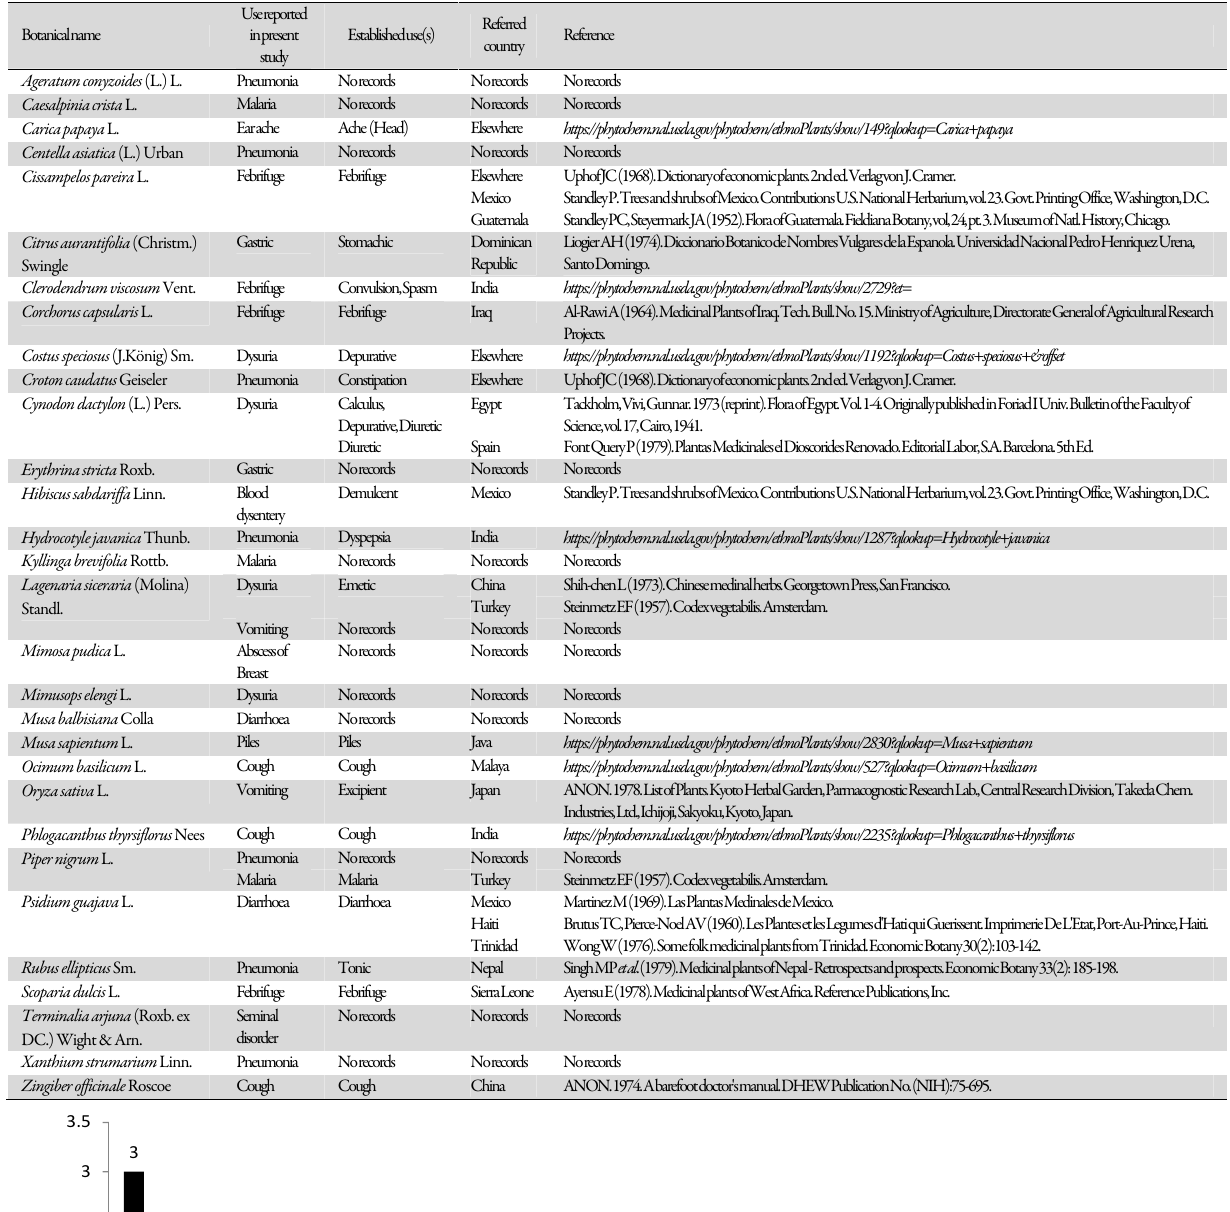
Use reported Referred in present Established use(s) Reference country study